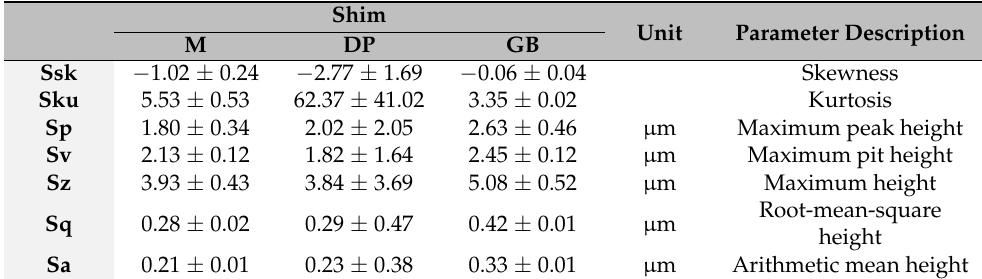
Table 3. Height (amplitude) parameters of surface roughness (S-L) for different shims. For each parameter, four measurements were conducted.